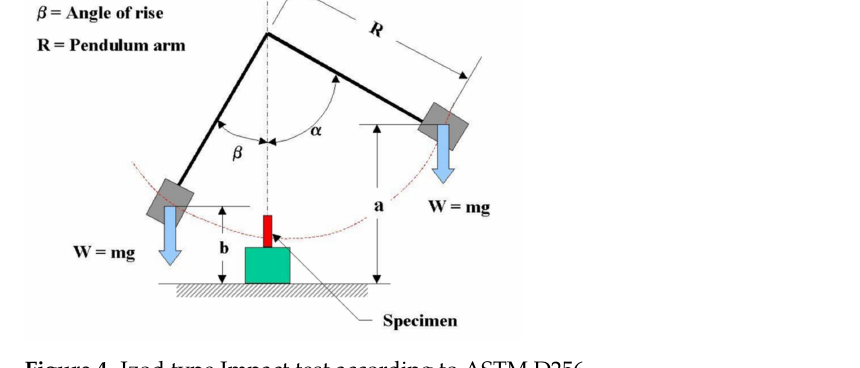
Figure 4. Izod type Impact test according to ASTM D256.